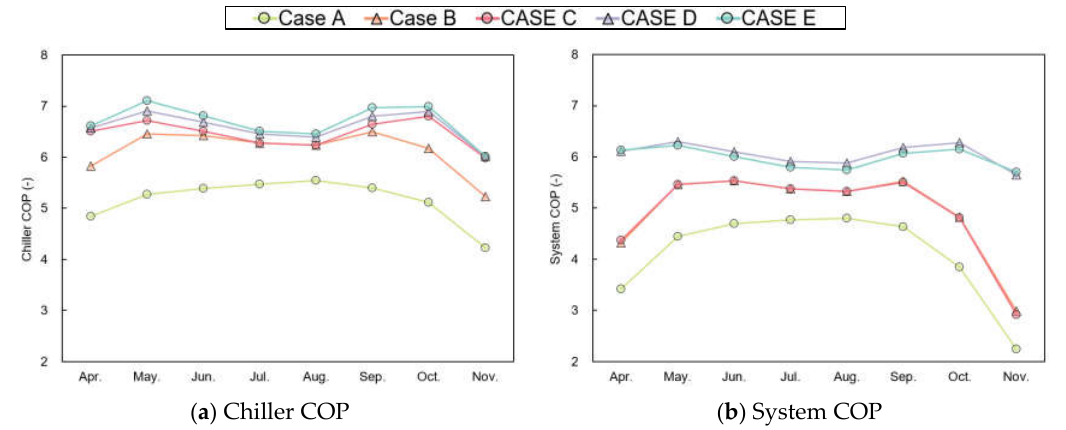
Figure 18. Monthly COP for Case A–E.